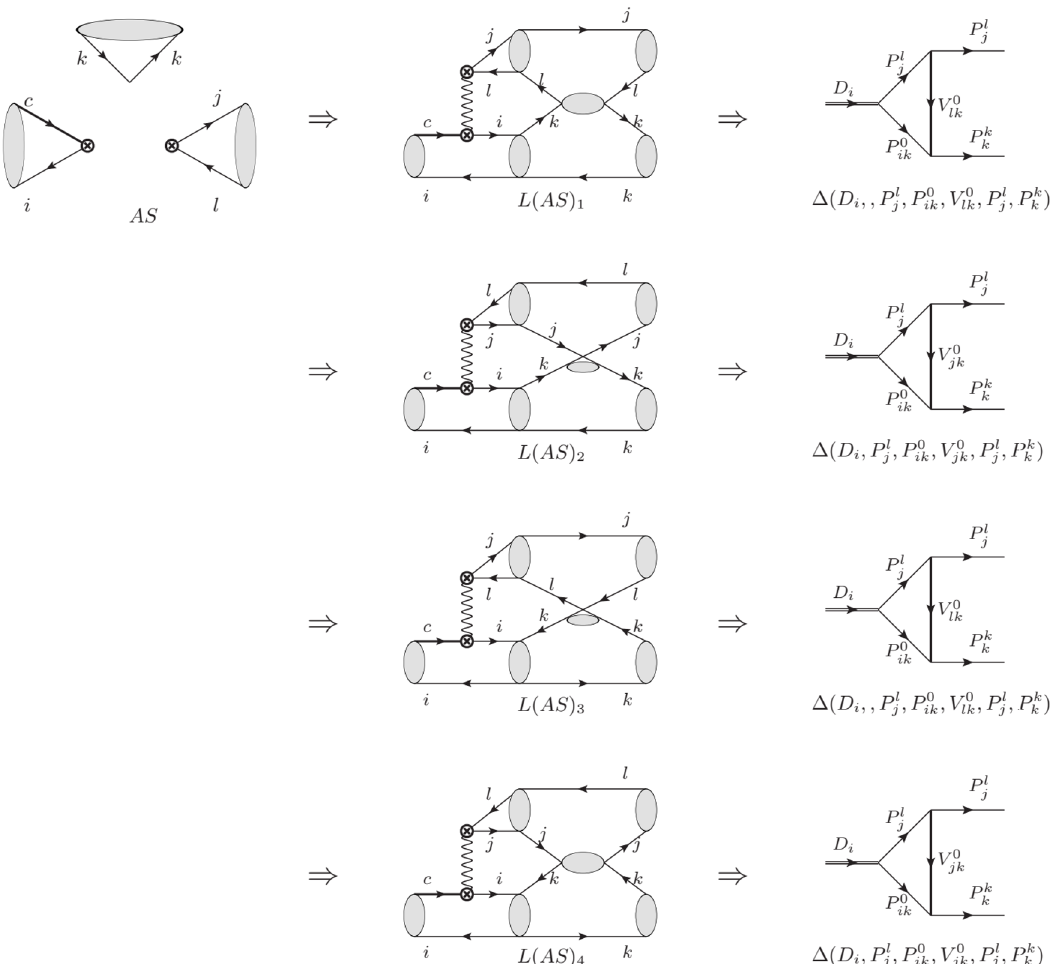
Figure 10 . Topological diagram ⇒ Topological-scattering diagram ⇒ Triangle diagram in T ⇒ AS transition.